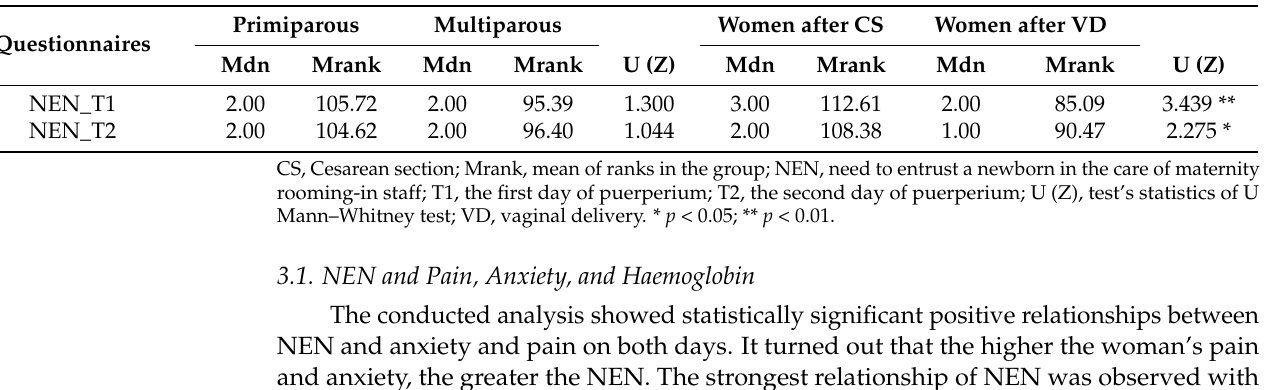
Table 1. Comparison of the magnitude of the need to entrust the newborn in the care of maternity rooming-in staff by parity and mode of